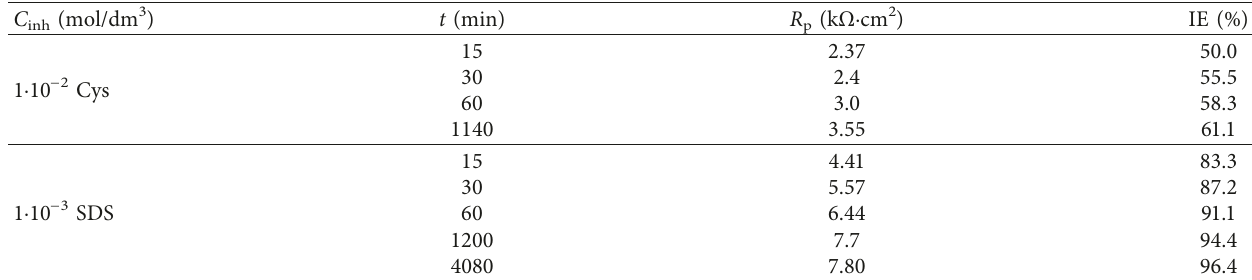
Table 4: Polarization resistance and inhibition efficiency for brass in acidic chloride solution after immersion in cysteine and SDS solutions for various periods of time. C inh (mol/dm 3